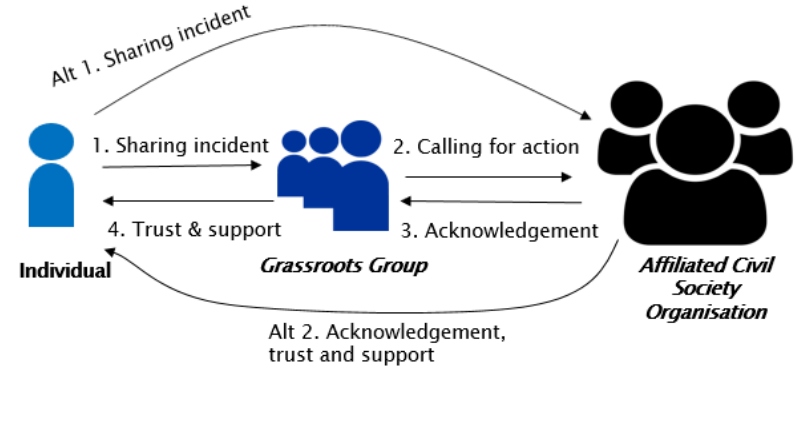
Figure 1: The Individual in the SMARTER